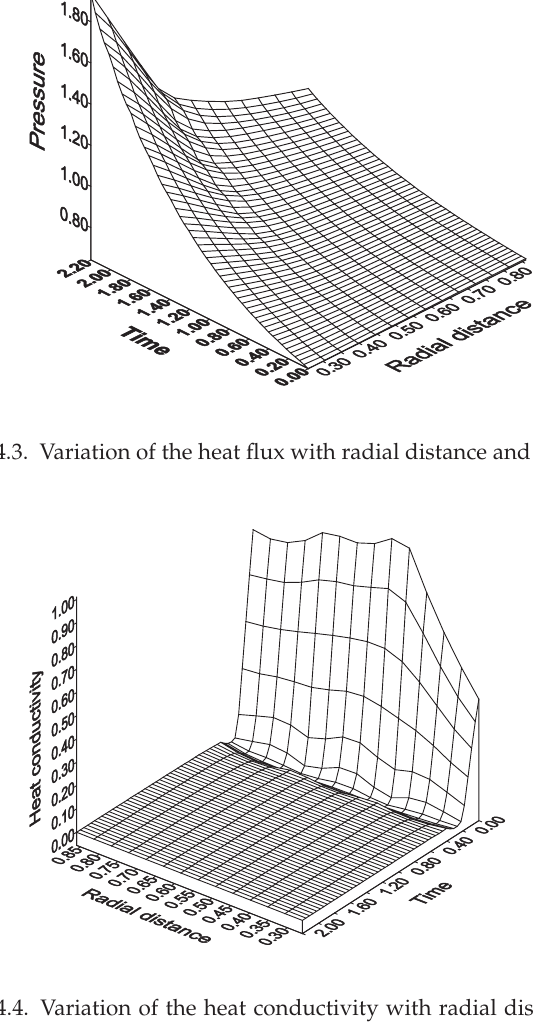
Figure 4.4 . Variation of the heat conductivity with radial distance and